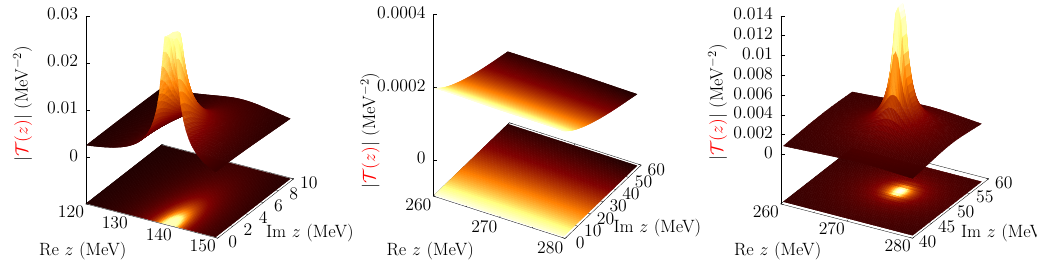
Figure 2: Left: π pole in the complex energy plane of the first Riemann surface at T = 25 MeV. Middle: No pole in the complex energy plane of the first Riemann surface at T = 250 MeV. Right: π pole after analytic continuation to the second Riemann surface at T = 250